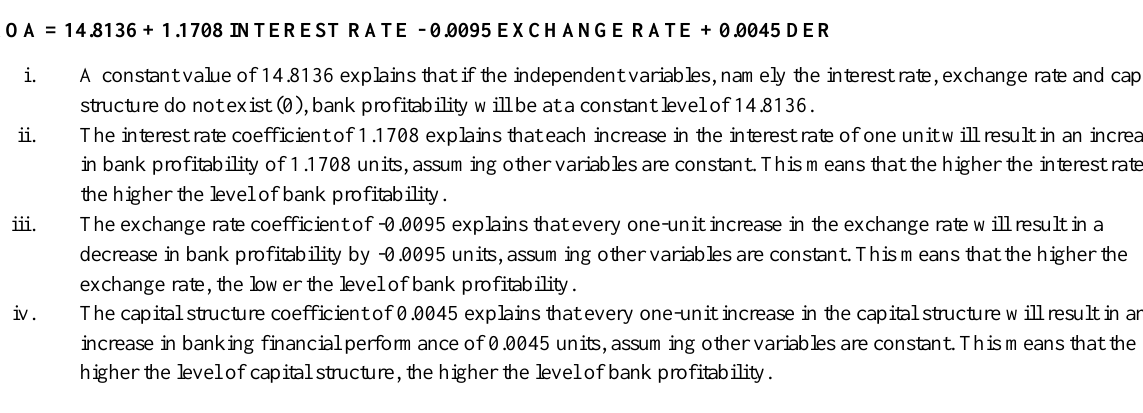
Based on table 5, the panel data regression equation model is obtained using the random effect model as follows: